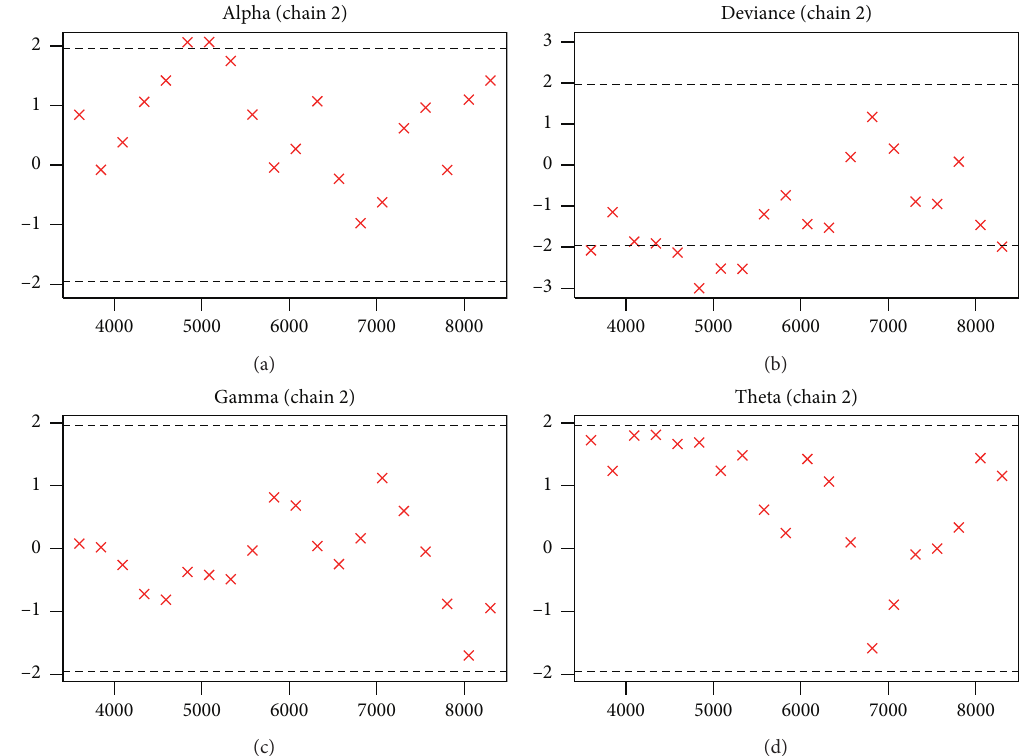
Figure 18: Geweke plot diagnostic (chain 2) for each parameter of NGE-Weibull distribution based on the failure time